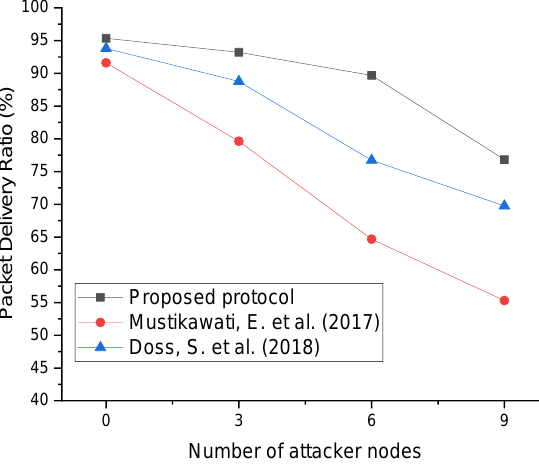
Figure 10. Packet delivery ratio under Jellyfish periodic drop attacks [20,37].